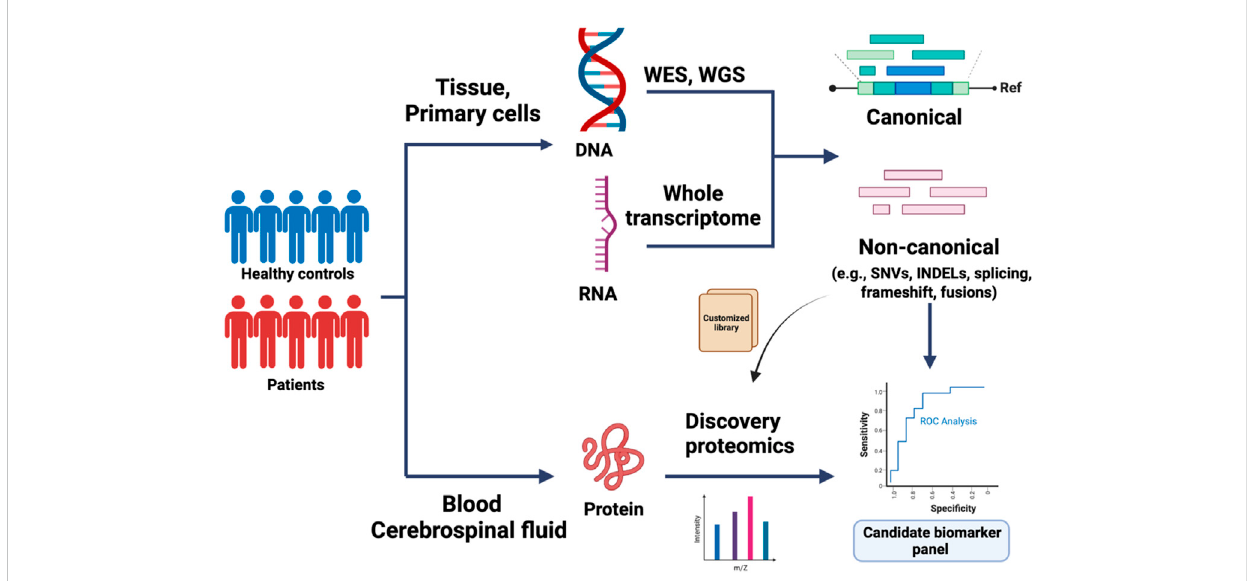
FIGURE 1 Application of proteogenomics in biomarker discovery. Whole-exome sequencing (WES), whole genome sequencing (WGS), and total RNA sequencing of control and patient-derived samples are used to identify canonical, or de novo reads matching to single nucleotide variants (SNVs), short insertions/deletions (indels), mis-splicing, or fusion transcripts. The variant coordinates are integrated within the normal protein sequence to build a custom peptide library. In parallel, discovery proteomics of bio fl uid samples can be used to build a proteomics database, which can be mined for sequences of interest using the custom-built peptide library. The candidate biomarkers are further validated in large-cohort